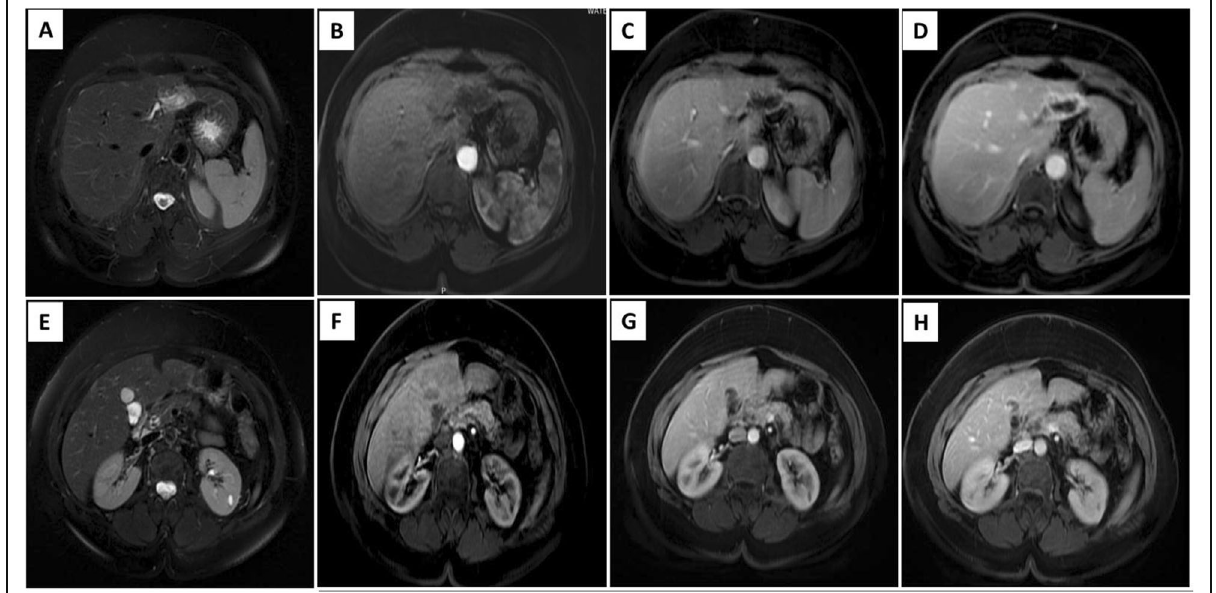
Fig. 1 a Axial fat suppression T2 showed a rather well-defined hyperintense left hepatic lobe segment II focal lesion surrounded by focal intrahepatic biliary radicles dilatation on background of non-cirrhotic liver. b Inconscipous enhacenemt in arterial phase c Mild ring enhancement in porto-venous and d Obvious ring enhacement in delayed phase of dynamic MRI. e Axial T2 fat suppression of the typical hemangioma showwd a rather well-defined bright left hepatic lobe segment IVb focal lesion, f Discontinuous peripheral nodular enhancement in arterial phase, g Centripetal fillin in porto-venous and h Closed iris sign in delayed equilibrium